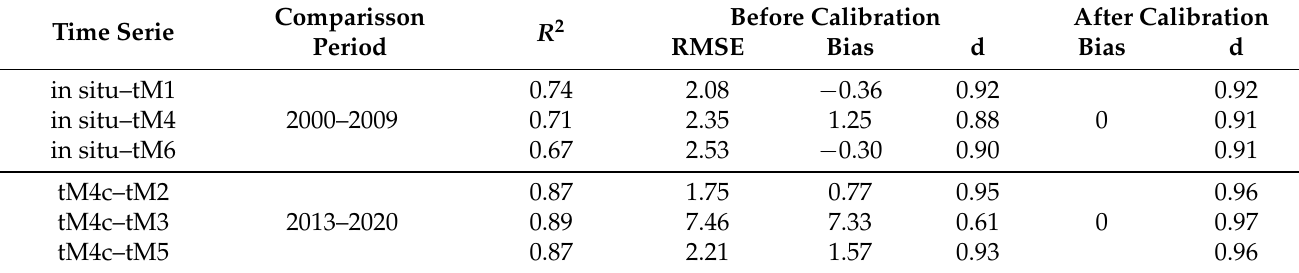
Table 7. Pairs of series to be calibrated with their respective statistics (bias, Willmott’s index of agreement (d), root mean square error (RMSE) and square of the correlation coefficient ( R 2 )). Average values over the three sampling stations (Desagüe (D), Centro (C) and Sur (S)) of Laguna Grande de San Pedro. Before and after calibration. Comparisson Time Serie